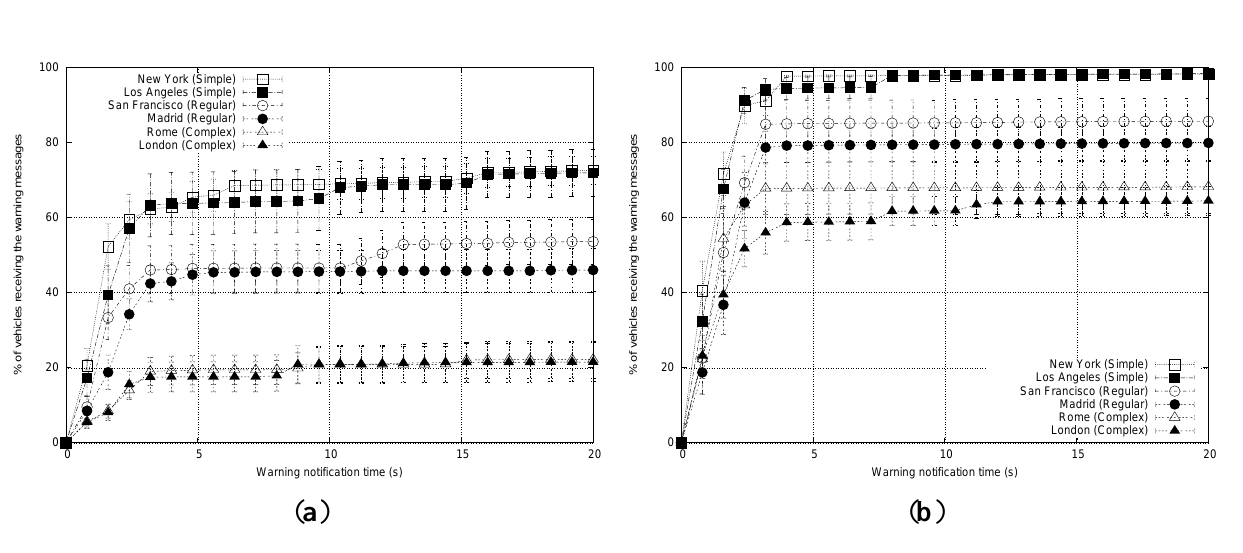
Figure 12. Number of messages received per vehicle simulating ( a ) the formerly presented scenarios, and ( b ) the additional street maps, under different vehicle